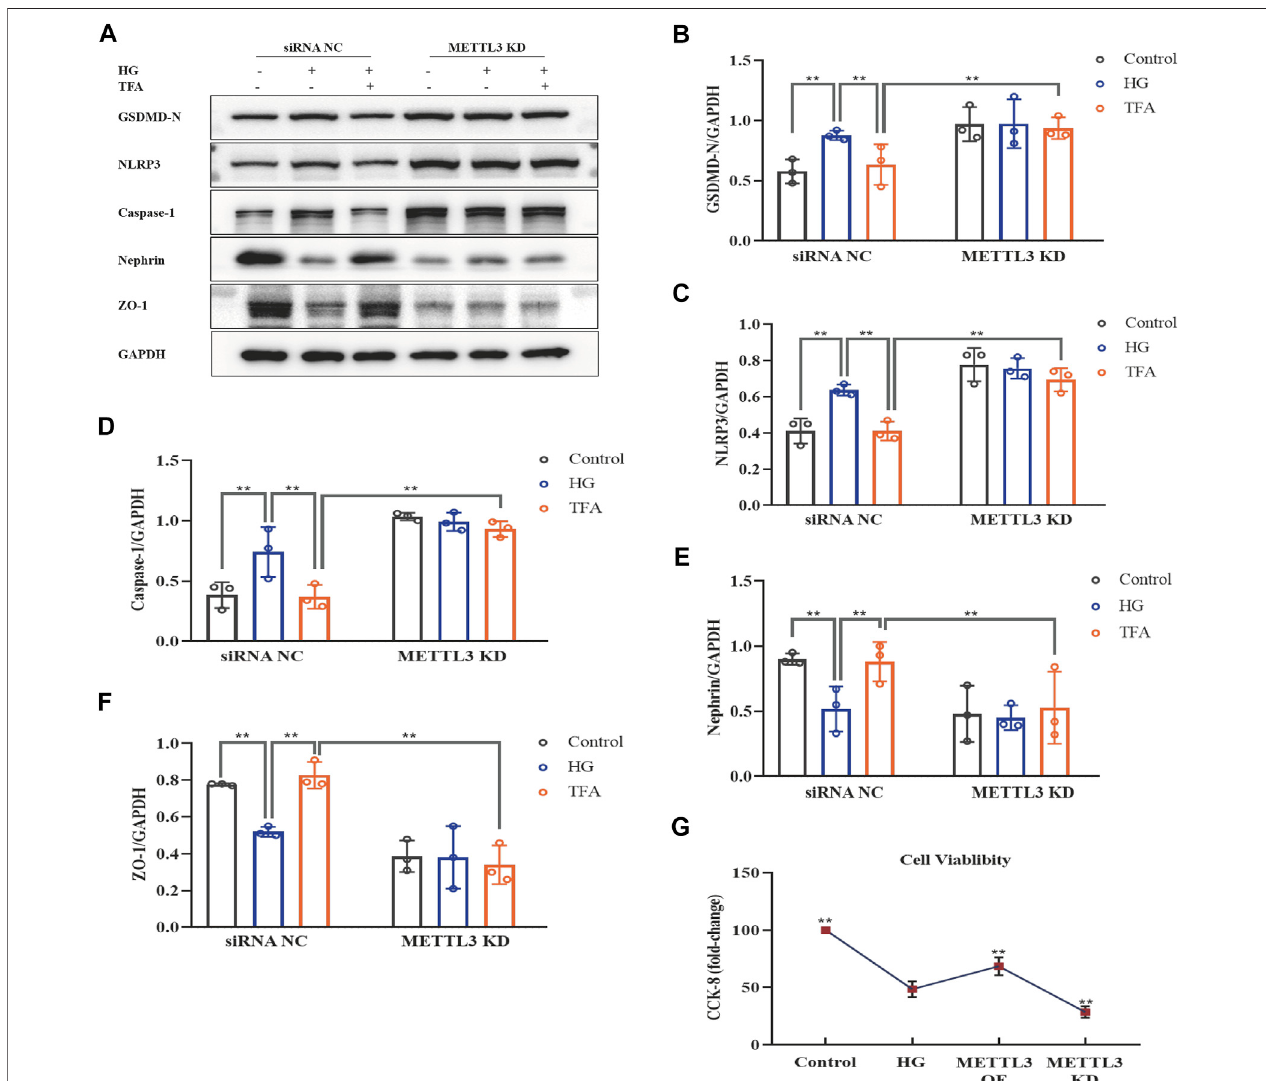
FIGURE 11 | TFA attenuated podocyte pyroptosis and injury in a METTL3-dependent manner by inhibiting the activation of the NLRP3 in fl ammasome in HG- af fl icted MPC-5cells with knockdown ofMETTL3. (A) WB analysis ofGSDMD-N, NLRP3, caspase-1, nephrin, and ZO-1, in cultured MPC-5 cells transfectedwith aNC siRNA or a METTL3 KD siRNA for 24 h, following by exposure to HG at 30 mM for 48 h with or without TFA (20 μ g/ml) for 24 h; (B) GSDMD-N was quanti fi ed by densitometry; (C) NLRP3 was quanti fi ed by densitometry; (D) Caspase-1 was quanti fi ed by densitometry; (E) Nephrin was quanti fi ed by densitometry; (F) ZO-1 wasquanti fi edbydensitometry; (G) ThecellviabilityinculturedMPC-5cellstransfectedwithMETTL3OEvectororMETTL3KDsiRNAfor24 hexposedtoHGat30 mM for 48 h. Data are expressed as mean ± S.D., (n (cid:2) 3). * p < 0.05, ** p < 0.01. Abbreviations: TFA, total fl avones of Abelmoschus manihot ; METTL, methyltransferase-like; NLRP3, NOD-like receptor pyrin domain-containing protein 3; HG, high glucose; MPC-5, mouse podocyte cell-5; WB, western blotting; GSDMD-N, N-terminus of GSDMD; Caspases-1, cysteinyl aspartate-speci fi c proteinase-1; ZO-1, Zonula occludens 1; NC, negative control; siRNA, small interfering RNA; KD, knockdown; OE,